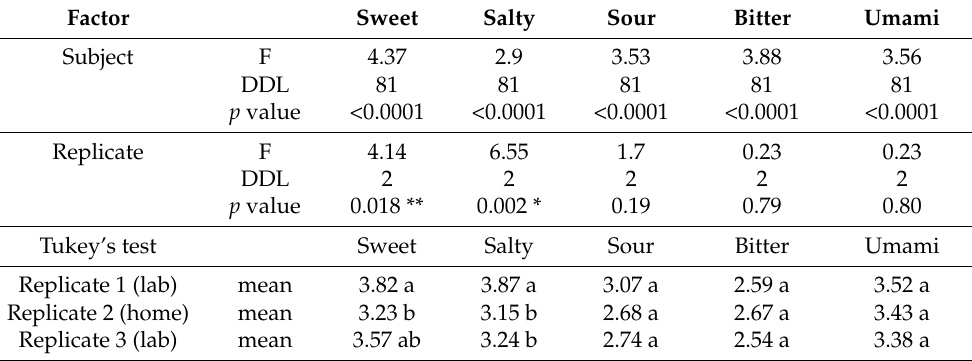
Table 2. Repeatability of measurements: ANOVA (type III; one analysis by taste); model: score = age group + sex + temperature level + frequency. p values: * p ≤ 0.05; ** p ≤ 0.01. Values with the